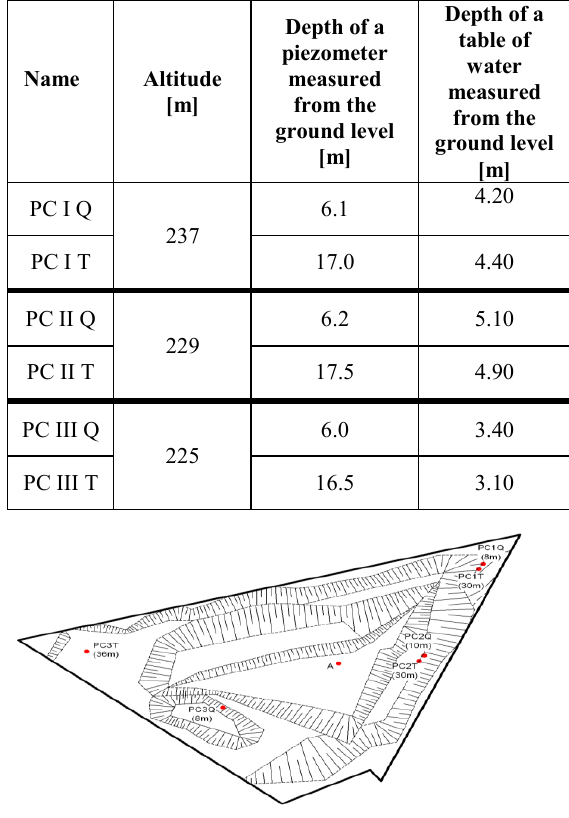
Table 1. Data pertaining to the ground water collection spots.